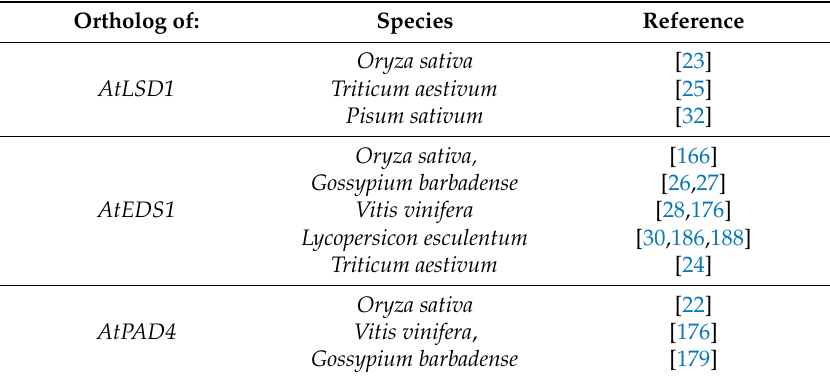
Table 2. Characterized orthologs of LSD1 , EDS1 and PAD4 in